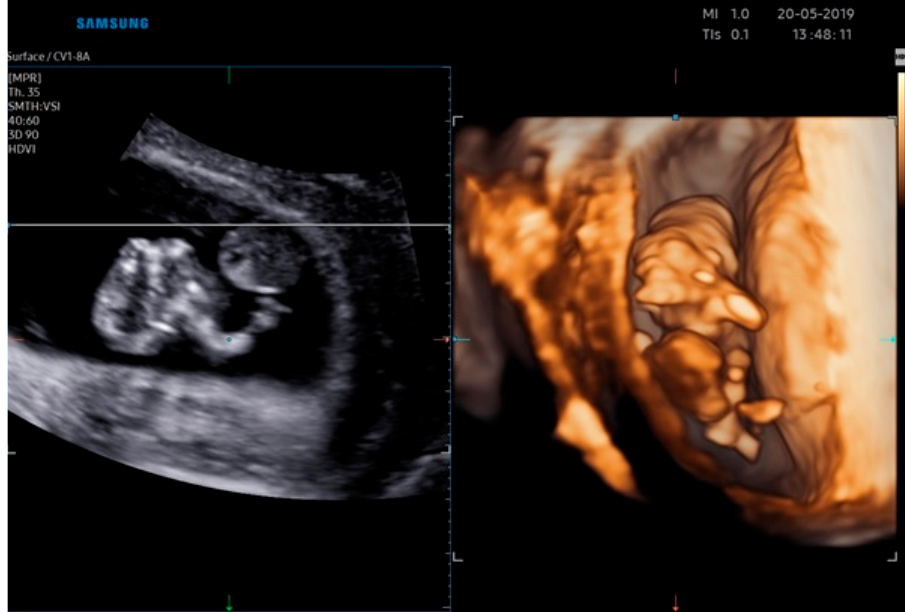
Figure 4. Realistic Vue image of case report 2 at 13 weeks.